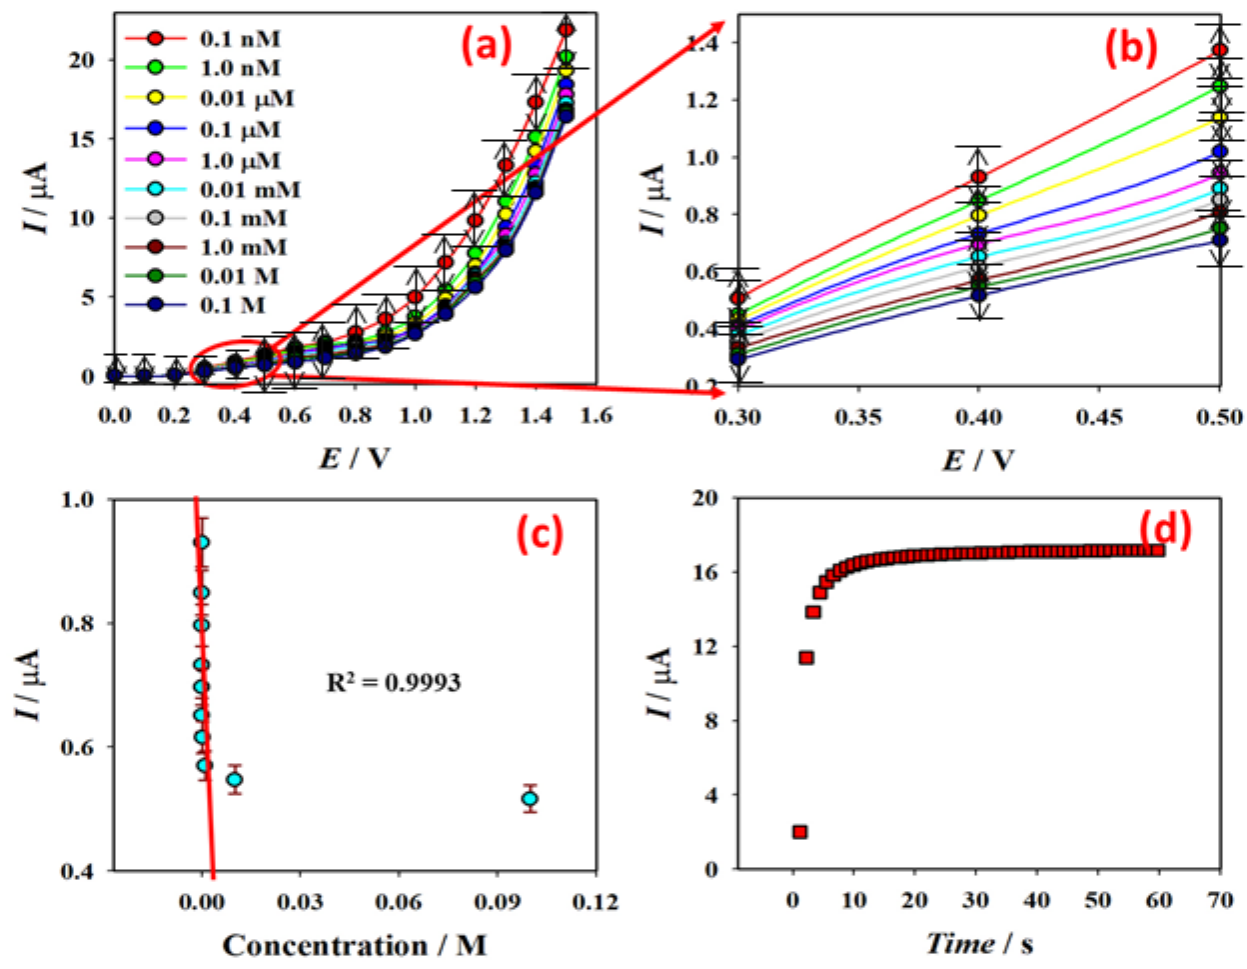
Figure 6. ( a ) Current variations for different concentration (0.1 nM to 0.1 M) of aqueous Hg 2+ ion in 0.0 to +1.5 V, ( b ) magnification of I-V responses at 0.4 V, ( c ) calibration plot of